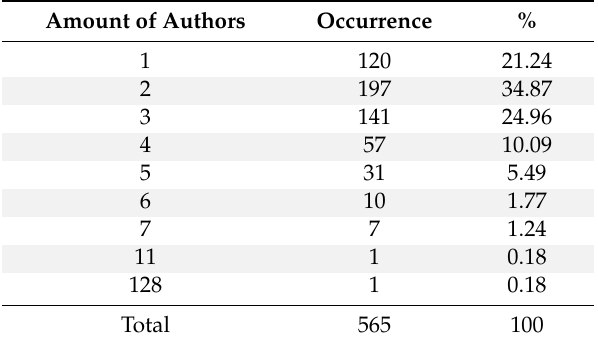
Table 13. Amount of authors associated per paper.